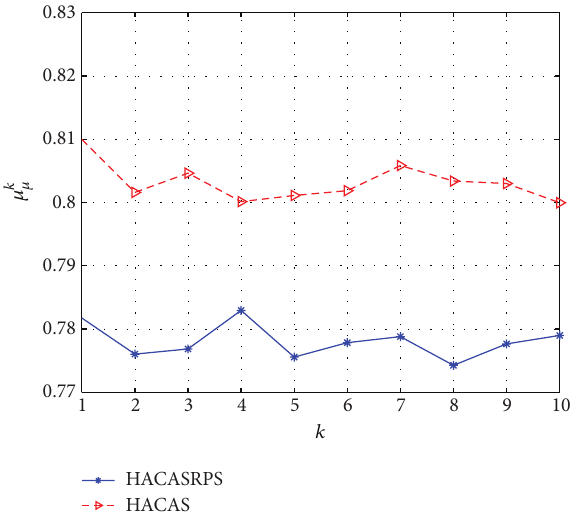
Figure 6: The average load of HACAS and HACASRPS algorithms in different simulation cycles; 𝑘 is the simulation cycle, and 𝜇 𝑘 𝜇 is the average load of the algorithm in the 𝑘 th cycle.